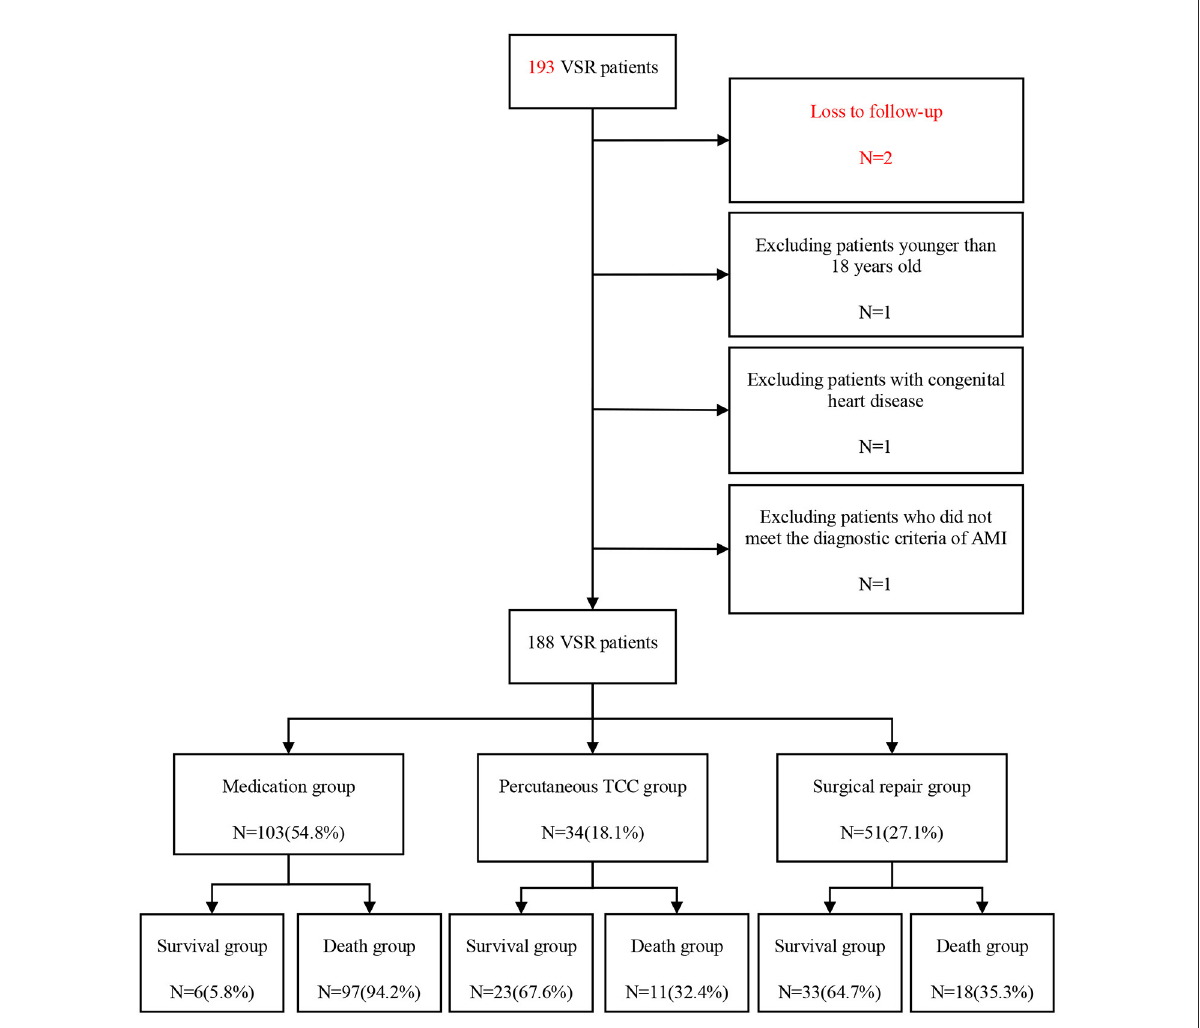
FIGURE1 Flow diagram of patient inclusion and exclusion. VSR, ventricular septal rupture; AMI, acute myocardial infarction; TCC, transcatheter closure.